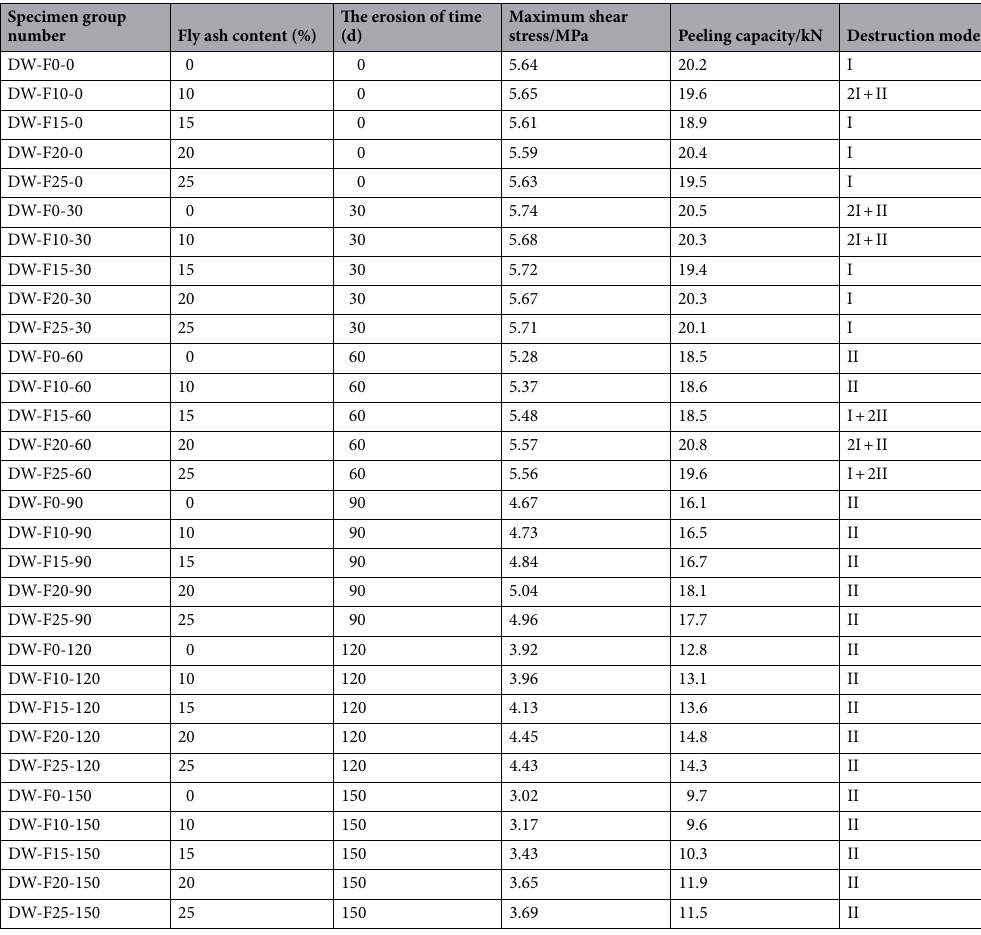
Table 5. Summary of test